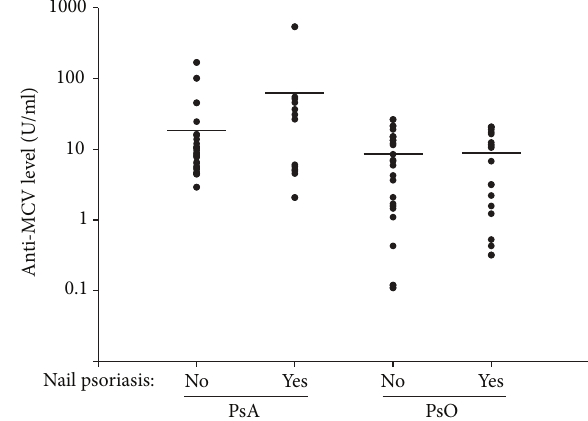
Figure 4: The anti-MCV levels demonstrate a significant inverse correlation with the age at the onset of the disease in the PsO patients. The plots represent the anti-MCV levels of the psoriasis patients and the age at the onset of psoriasis ( 𝑃 = 0.019 ).